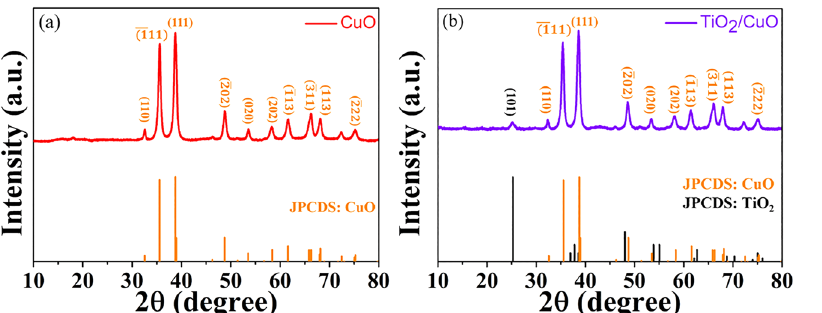
Figure 2: X-ray diffraction (XRD) patterns of the prepared (a) CuO and (b) TiO 2 /CuO nanomaterials.